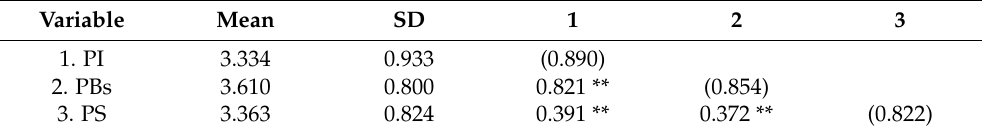
Table 2. The mean, standard deviation and correlation coefficient of variables (N =